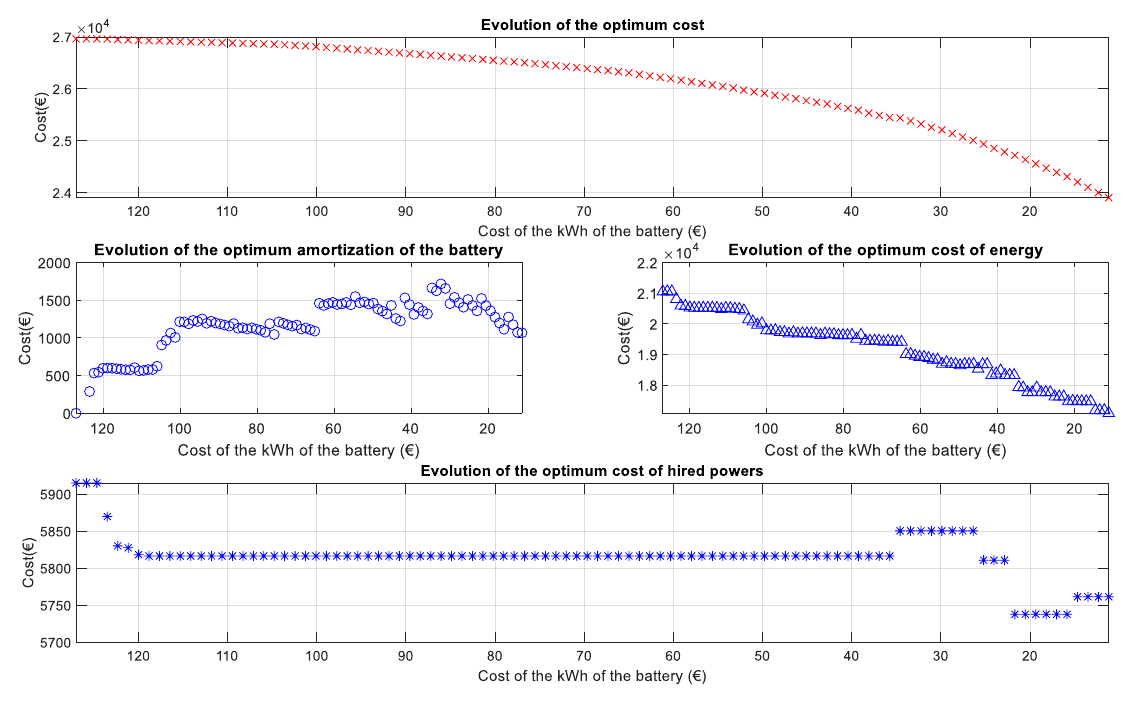
Figure 7. Optimal cost ( € = EUR) for each PSO algorithm’s execution during the sensitivity algorithm.